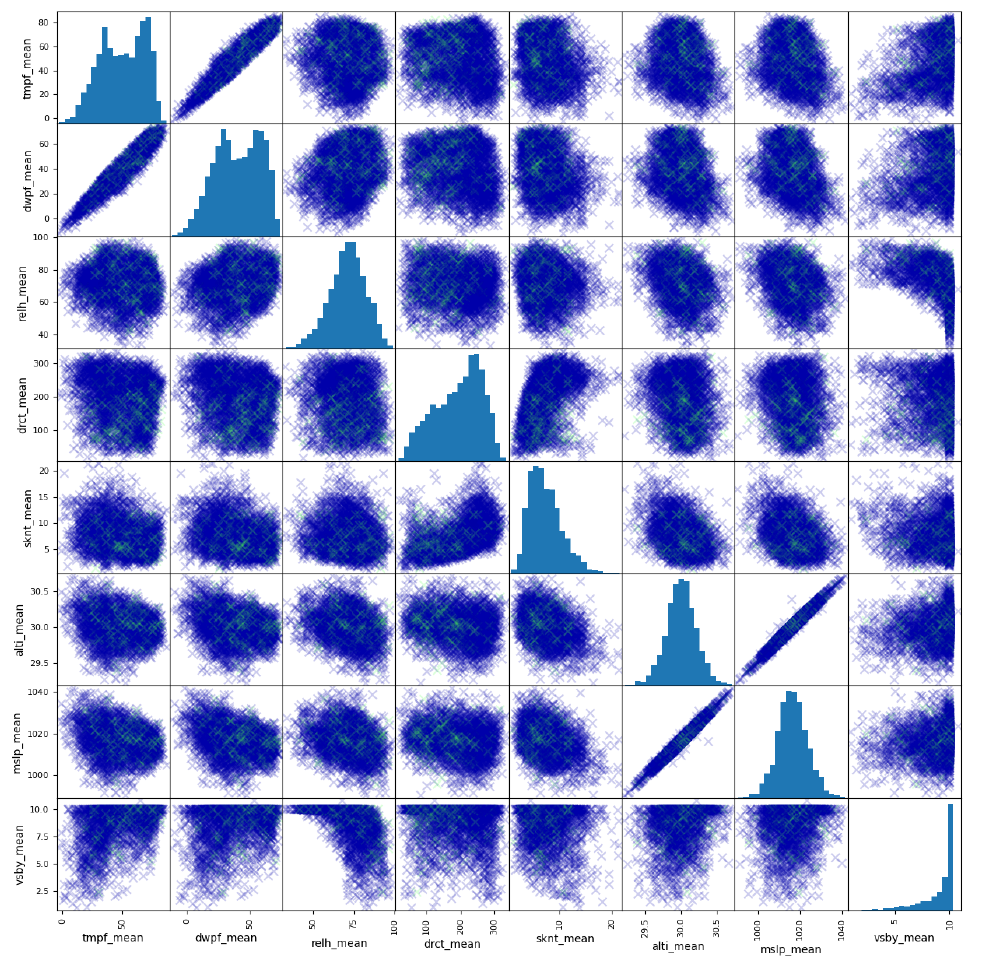
Figure 3. The feature matrix in ROC dataset. Notation: tmpf, air temperature in Fahrenheit typically at 2 m; dwpf, dew point temperature in Fahrenheit typically at 2 m; relh, relative humidity in %; drct, wind direction in degrees from north; sknt, wind speed in knots; alti, pressure altimeter in inches; mslp, sea level pressure in millibar; vsby, visibility in